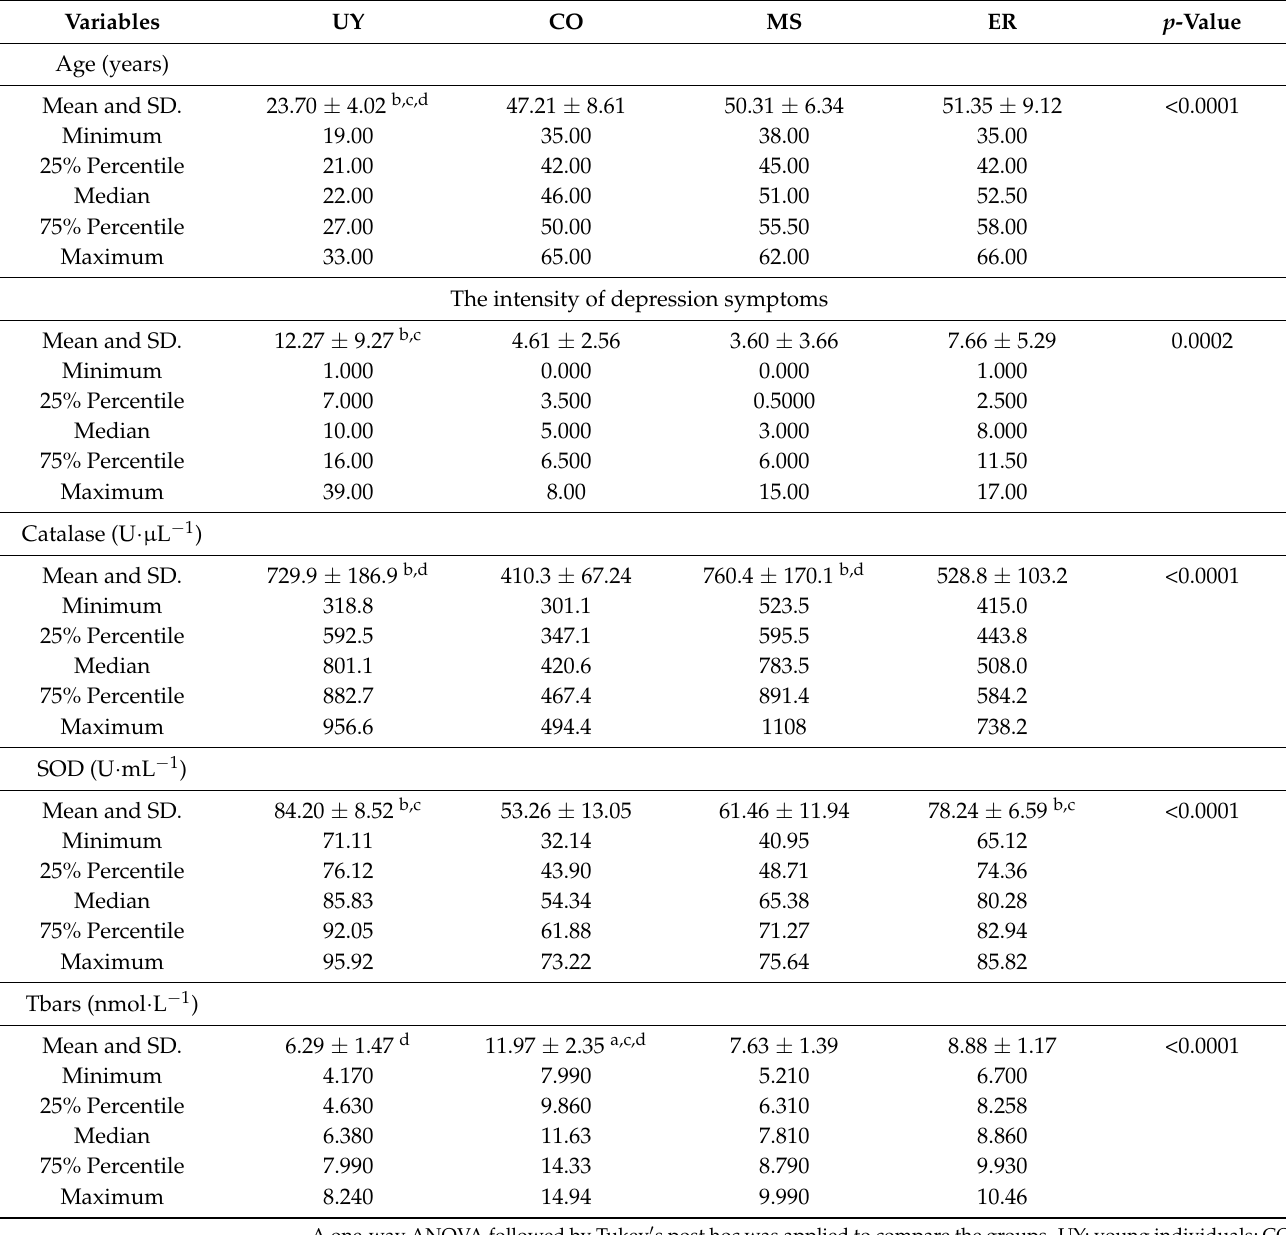
Table 1. Age, intensity of depression symptoms, catalase, SOD, and Tbars of UY, CO, MS, and